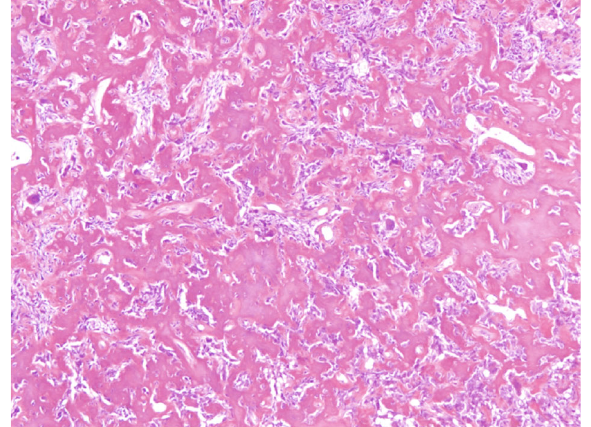
Figure 4: Histologic analysis demonstrating the characteristic pink- staining osteoid in a fi brovascular stroma (H&E staining, ×